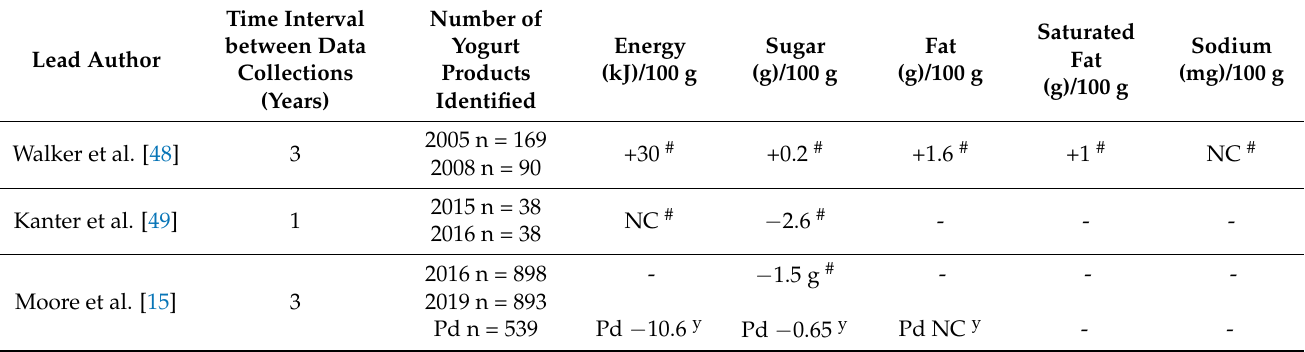
Table 4. Energy (kJ) and nutrient changes in the three studies investigating the reformulation of yogurt over